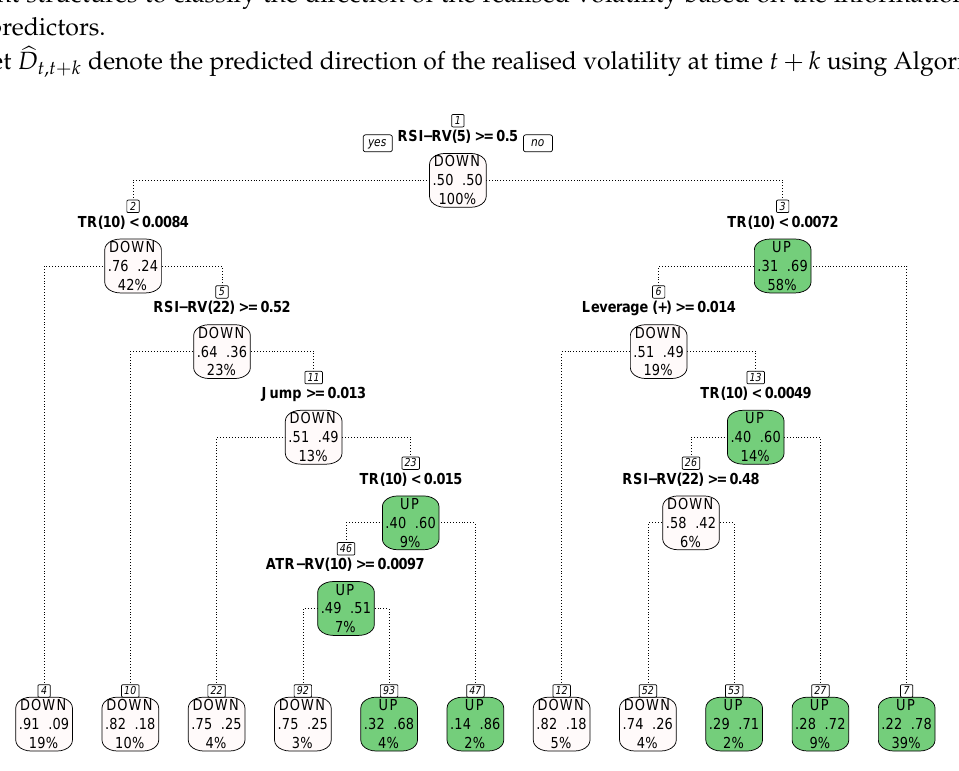
Figure 2. A possible decision tree for classifying the daily realised volatility direction using the technical indicators from the previous day.